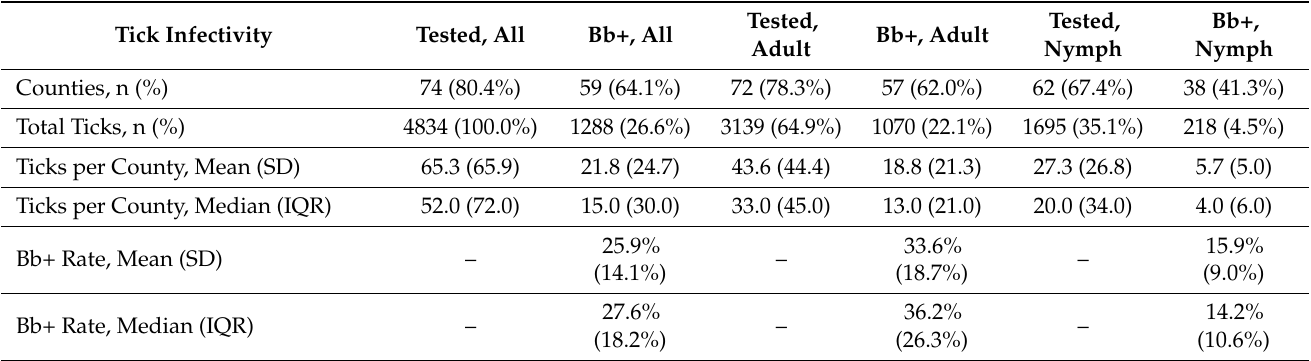
Table 5. Summary statistics of tick infectivity across 2017–2020 as reported by the Indiana Department of Health. Ticks—divided into Adults and Nymphs—were submitted for testing were assayed for the presence of Bb, the main bacterial agent responsible for Lyme Disease. The table presents the number (%) of counties that tested ticks or at reported least one Bb+ tick (see column headers), and the total number (%) of tested ticks or Bb+ ticks across counties as means and medians, both for the raw totals and the percentage rate of Bb+ infectivity. Only counties with at least one tested tick or Bb+ tick (see column headers) were considered when calculating these statistics. IDOH = Indiana Department of Health; Bb = Borrelia burgdorferi ; SD = Standard Deviation; IQR = InterQuartile